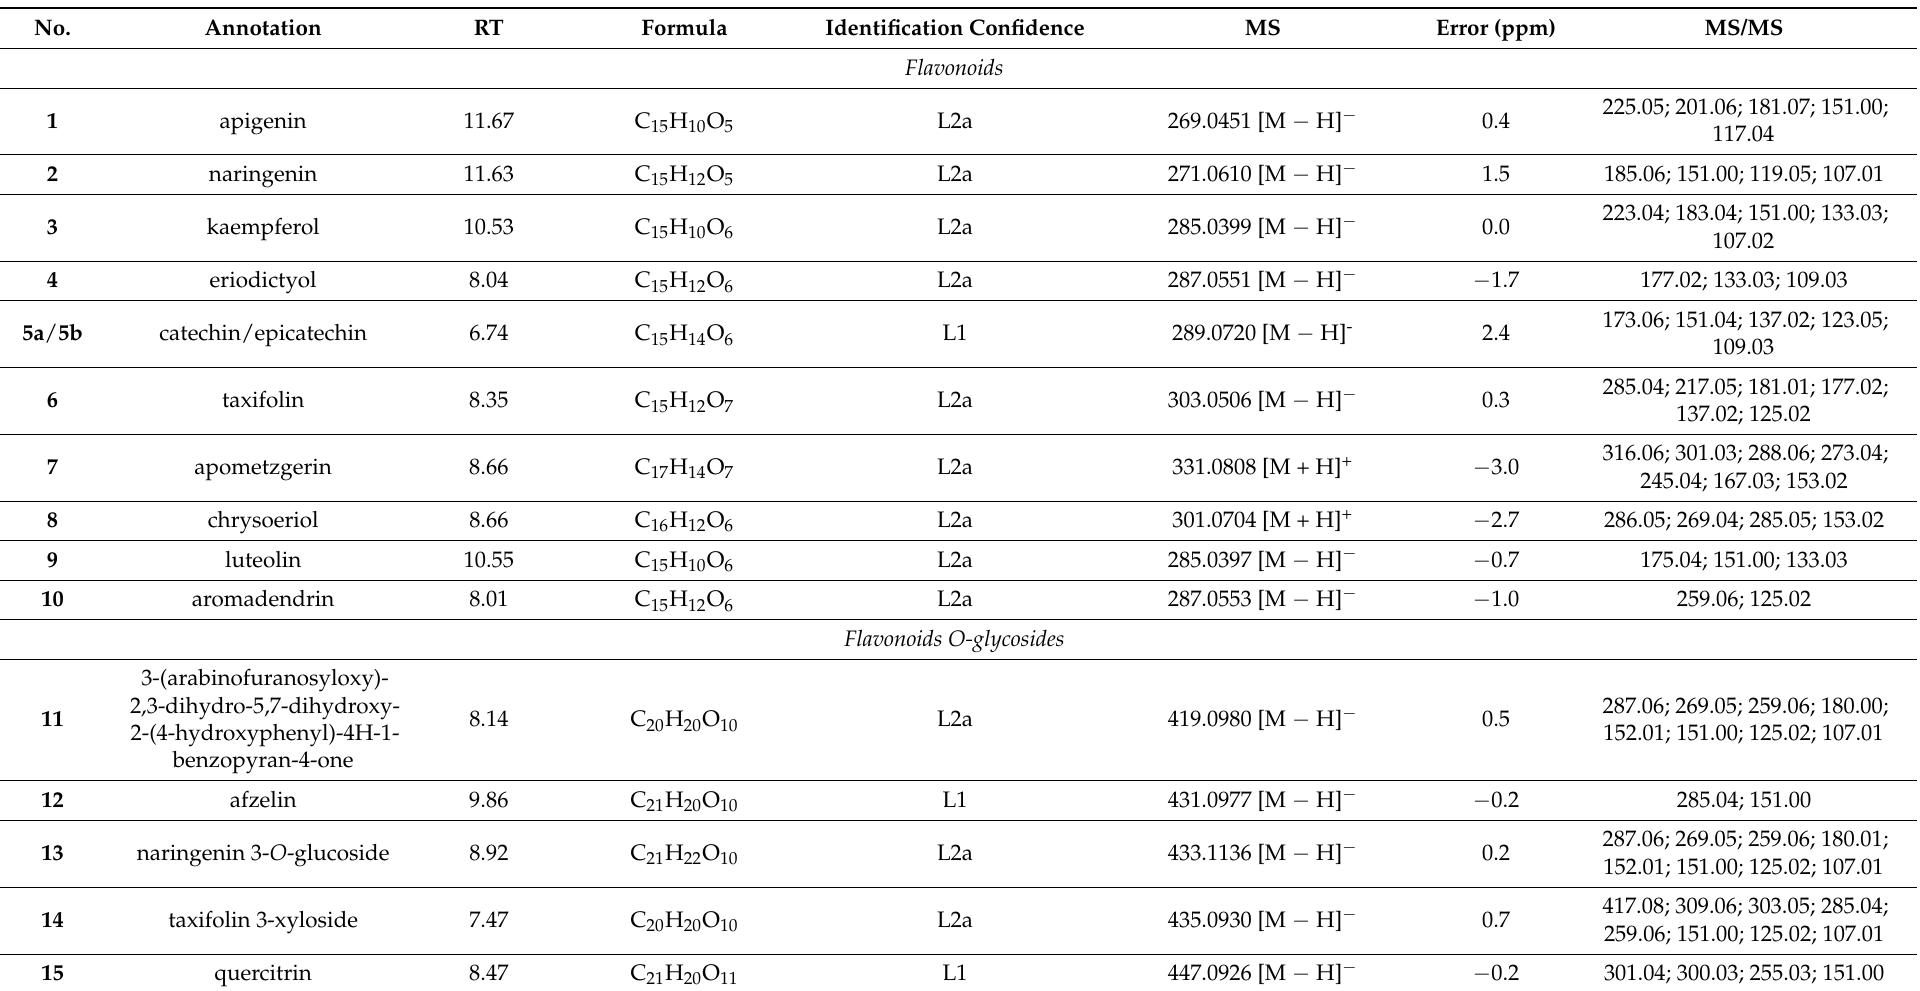
Table 1. Compounds detected in the Anomalocalyx uleanus methanolic extracts by UPLC-Q-TOF-MS/MS (compounds 1 – 46 ) and gas chromatography-mass spectrometry (GC-MS) ( 47 – 50 ). Level of confirmation: Level 1 (L1): structure confirmed by reference standard or structure elucidation by NMR spectroscopy, level 2a (L2a): probable structure by library spectrum match, and level 3 (L3): tentative candidates based on MS and MS 2 experimental data